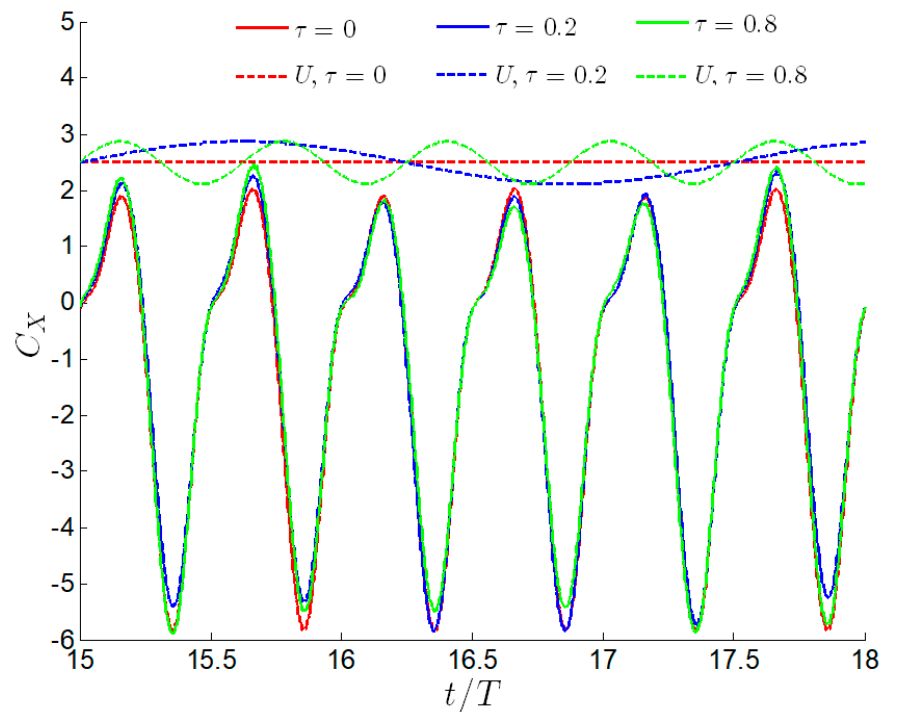
Figure 10. The evolution of the instantaneous thrust coefficient and freestream velocity over three periods for f ∗ = 0.68, θ 0 = 60 ° .